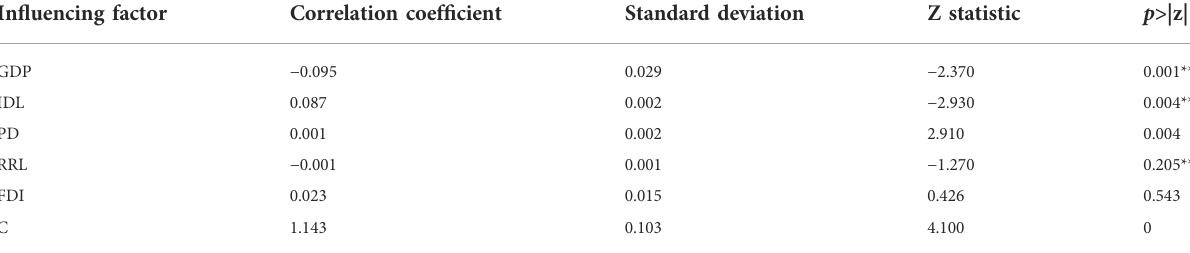
TABLE 5 Tobit regression